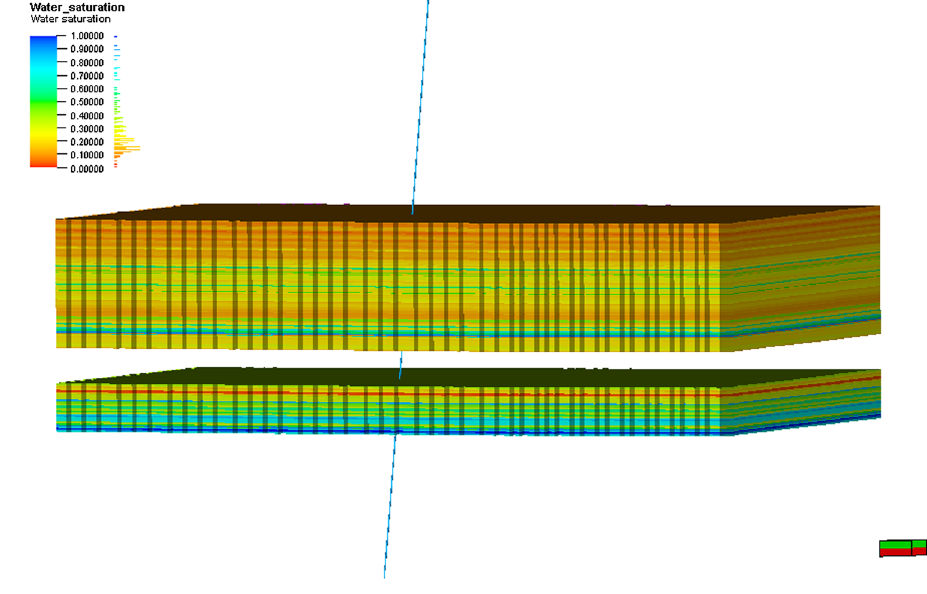
Fig. 20 Single well model showing water saturation (derived from MICP data)